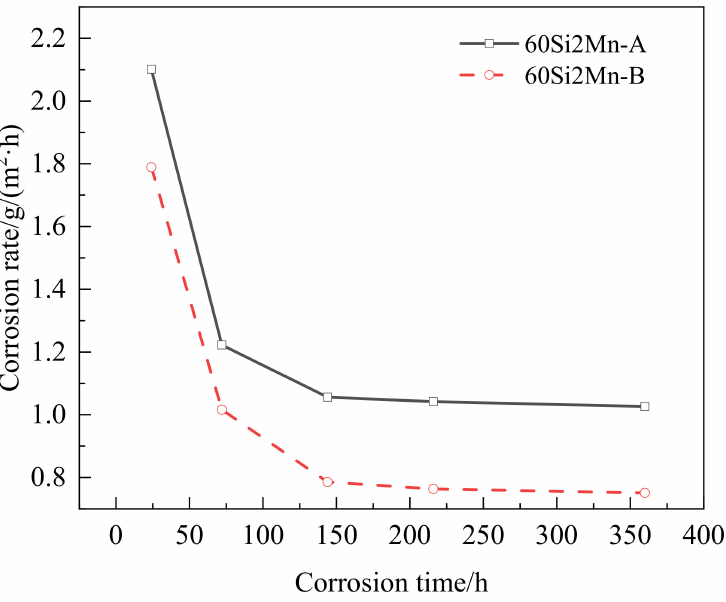
Figure 1. Curves of corrosion miss-loss rate of tested steels as a function of cycling